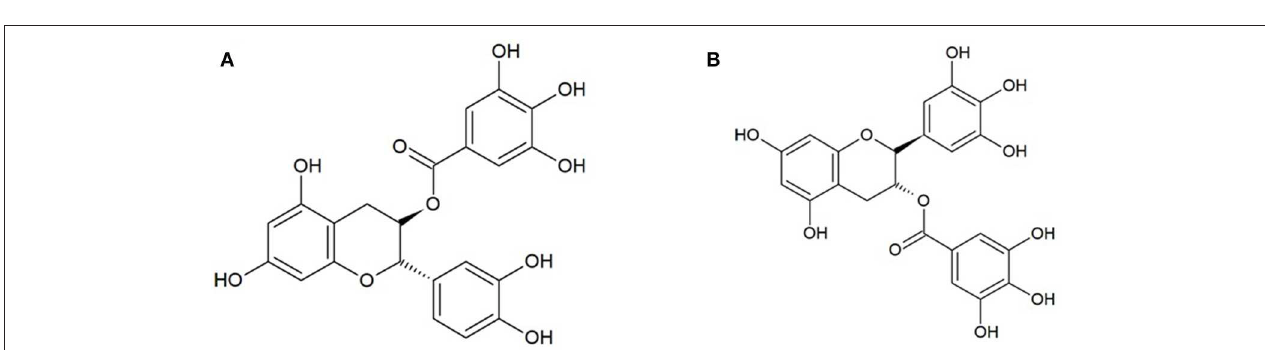
FIGURE 4 | Catechins. (A) (-)-catechin gallate (C 22 H 18 O 10 ); (B) (-)-gallocatechin (C 22 H 18 O 11 ).